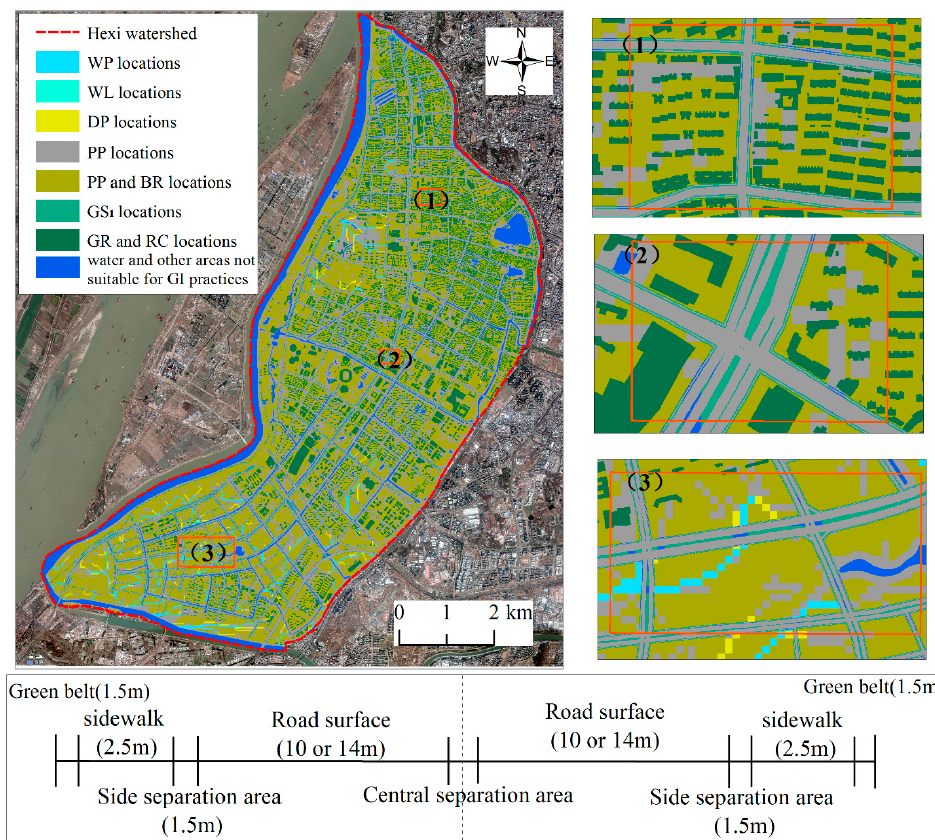
Figure 3. Suitable locations of GI practices. Table 2. Criteria for GI practice locations [37,55,56].